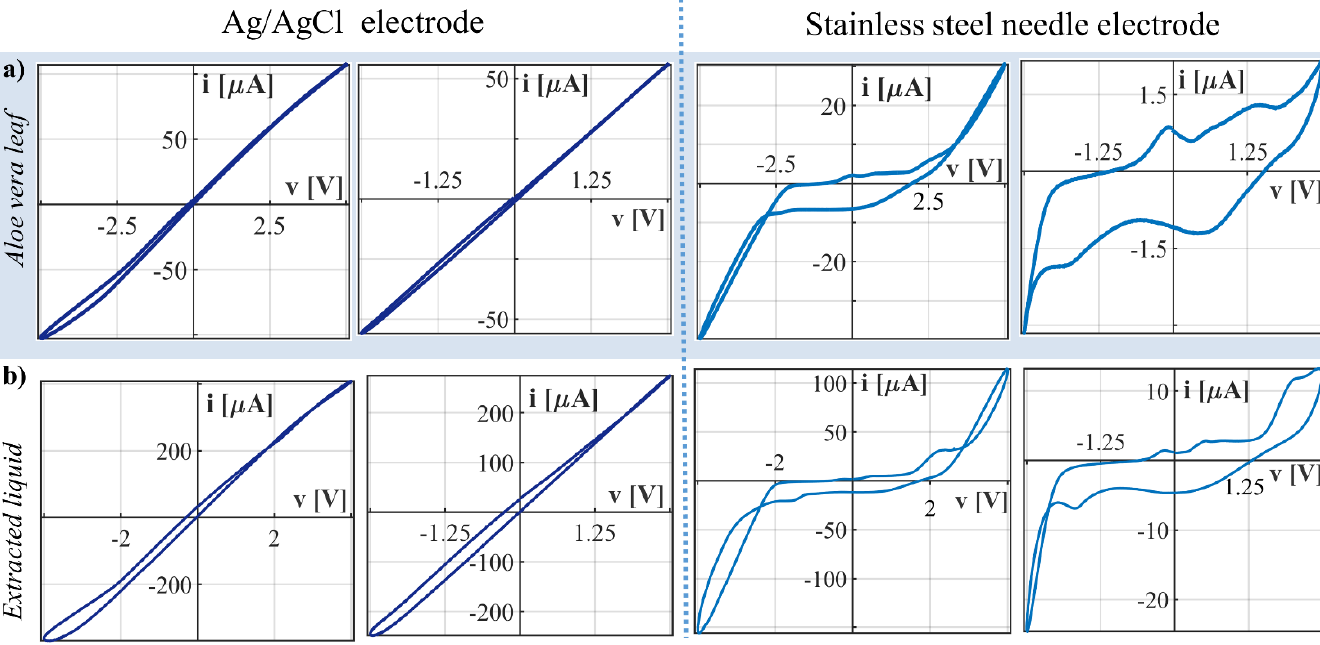
Fig. 2: Voltage current plots recorded from the aloe vera plants, always shown for the second period of each measurement. The dark blue plots represent the results from recordings with the silver/silver chloride electrode and the light blue plots from the recordings with the medical stainless steel needle electrode. a ) Results from one leaf of one aloe vera plants (A) shown for applied sinusoidal voltages with amplitudes of 5 V and 2.5 V and frequency equal to 0.005 Hz. The recordings obtained by the silver/silver chloride electrode are slightly non-linear. Pinched hysteresis loops with small loop area and pinched point position in the first quadrant were obtained. b ) Results from the liquid of one leaf of one aloe vera plant shown for applied sinusoidal voltages with amplitudes of 4 V and 2.5 V and a frequency of 0.005